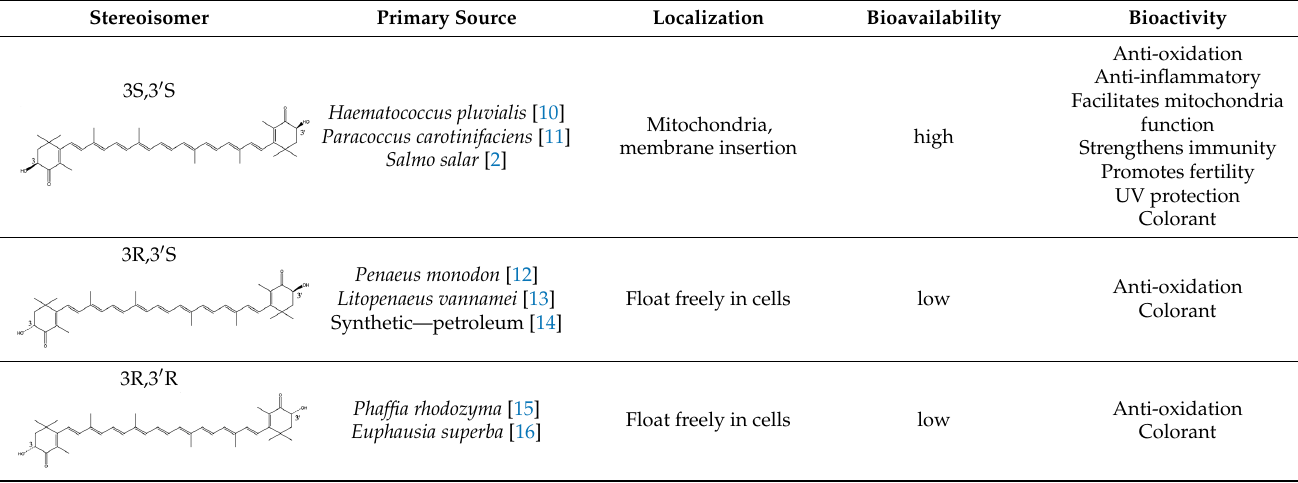
Table 1. Characteristics of astaxanthin stereoisomers.